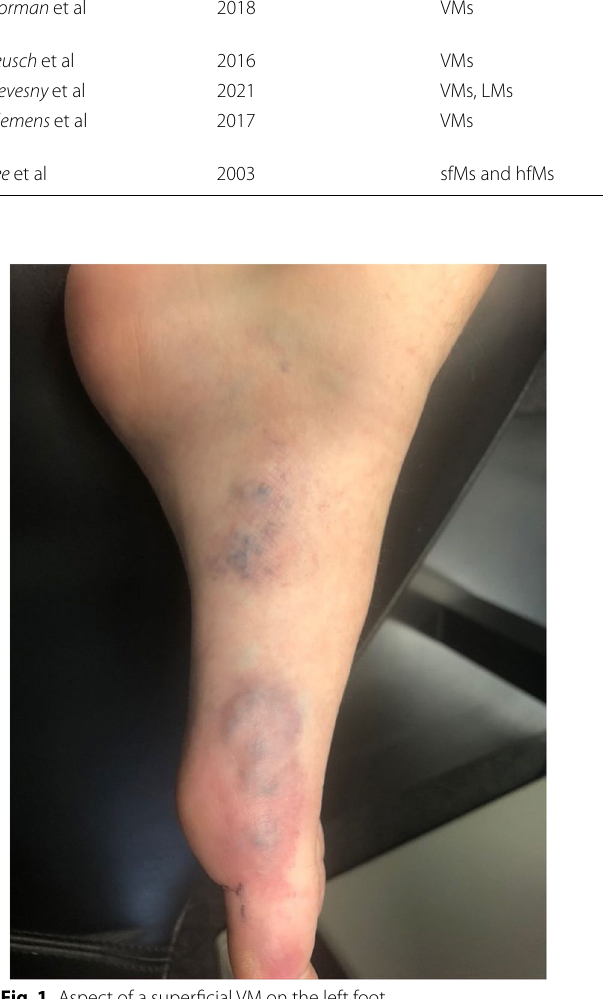
Fig. 1 Aspect of a superficial VM on the left